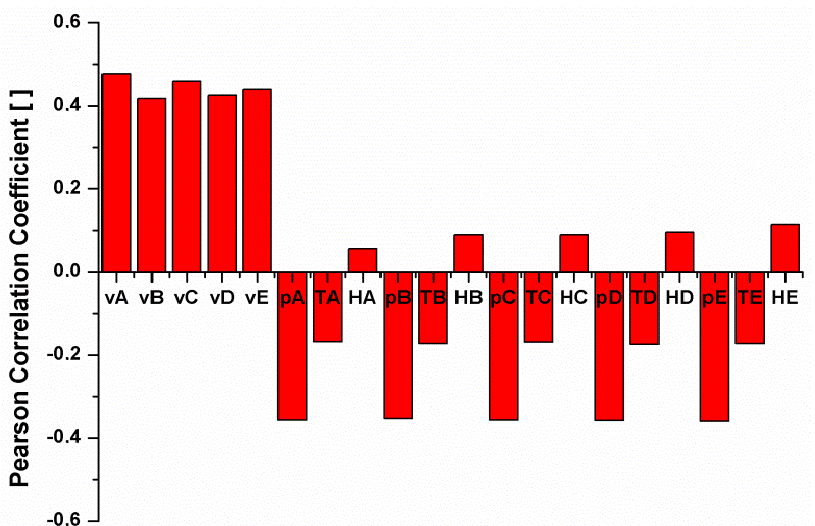
Figure 2. Pearson’s correlation coefficient for weather